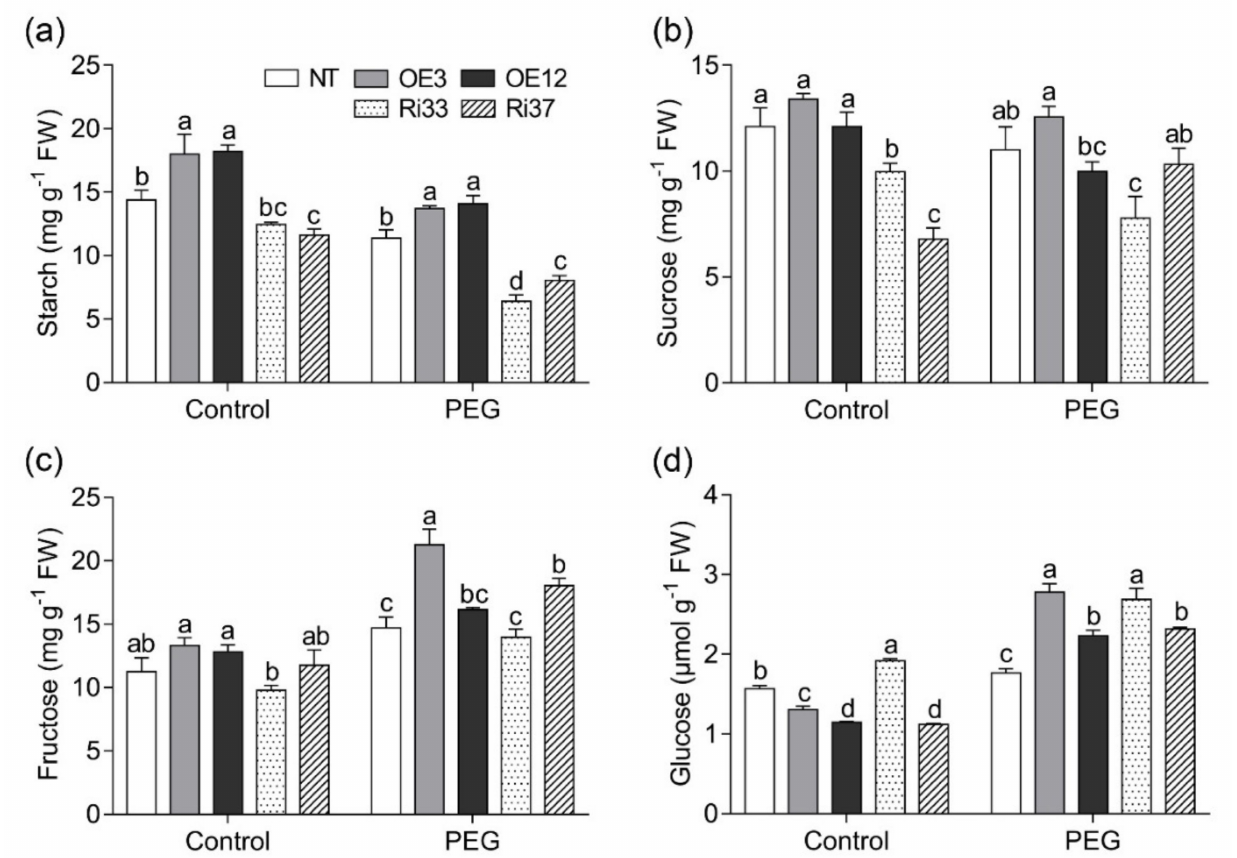
Figure 4. Effects of CgbHLH001 overexpression on carbohydrate fractions of maize seedlings under drought stress. ( a ) Starch; ( b ) sucrose; ( c ) fructose; ( d ) glucose. NT, non-transgenic plant; OE3 and OE12, CgbHLH001 -overexpressed T 3 maize lines; Ri33 and Ri37, ZmbHLH -RNAi T 3 maize lines. PEG, 15% PEG 6000. Different lowercase letters above the columns indicate significant differences between NT plants and transgenic lines under the same condition (Tukey’s test, p < 0.05). Values are means ± SD of three